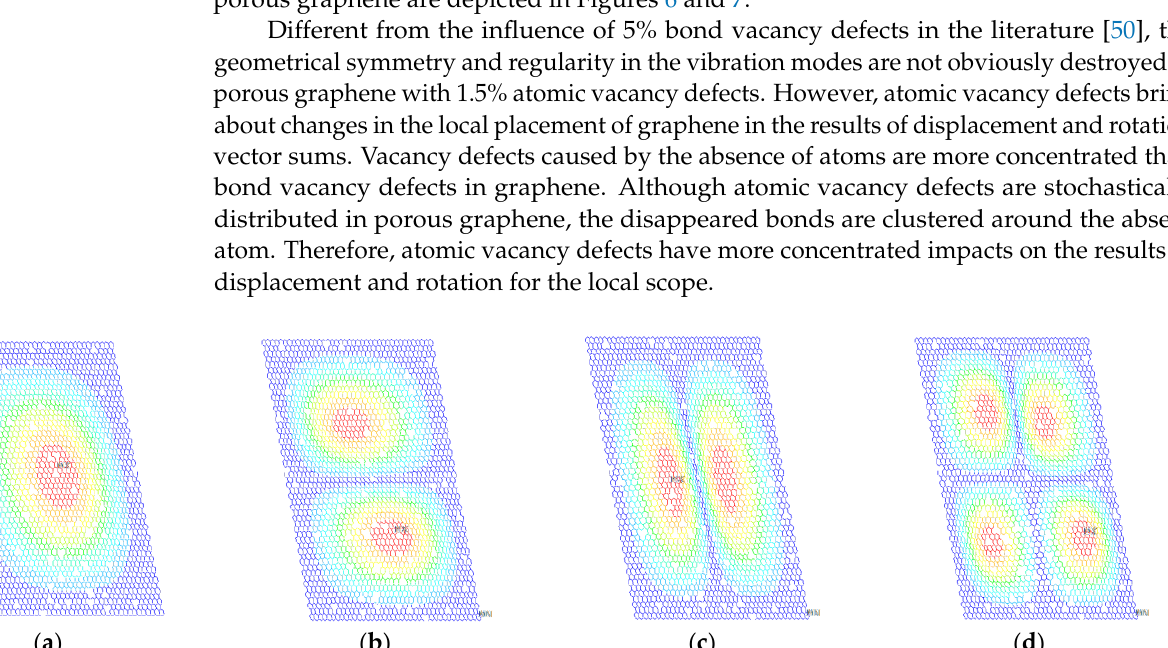
Figure 5. Variance of resonant frequencies for porous graphene (RF1-RF4 are the variance of reso- nant frequencies in the first- to fourth-order vibration modes; A and B represent the atomic and bond vacancy defects, respectively).